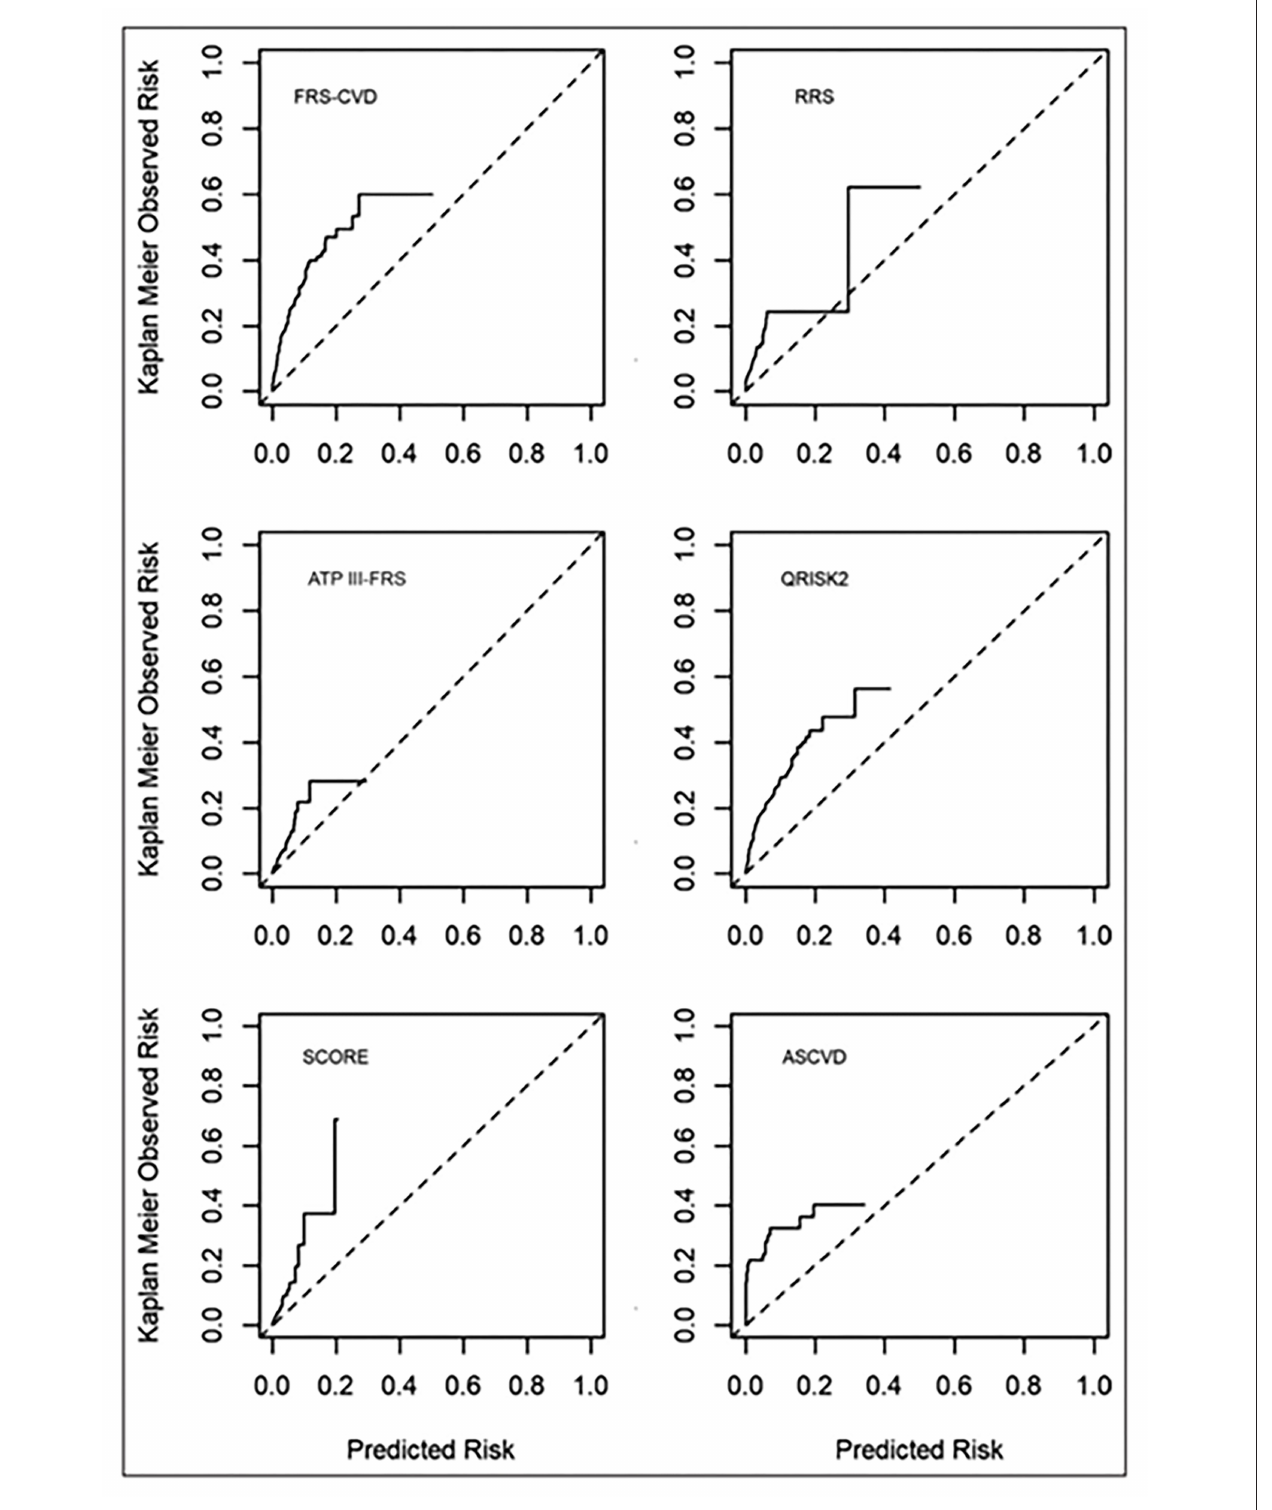
FIGURE 3 | Calibration plots of risk score-specific predicted vs. observed rate of events. Commonly used cardiovascular risk scores significantly underestimate risk in women with ischemia and no obstructive CAD. Dotted line is the reference line for equal predicted and observed risk. Solid line is the observed risk. ASCVD, Atherosclerotic Cardiovascular Disease risk score; ATP III-FRS, Adult Treatment Panel III risk score; FRS, Framingham Risk Score; QRISK2, cardiovascular risk score; RRS, Reynolds Risk Score; and SCORE, Systematic Coronary Risk Evaluation. Reprinted with permission (66).